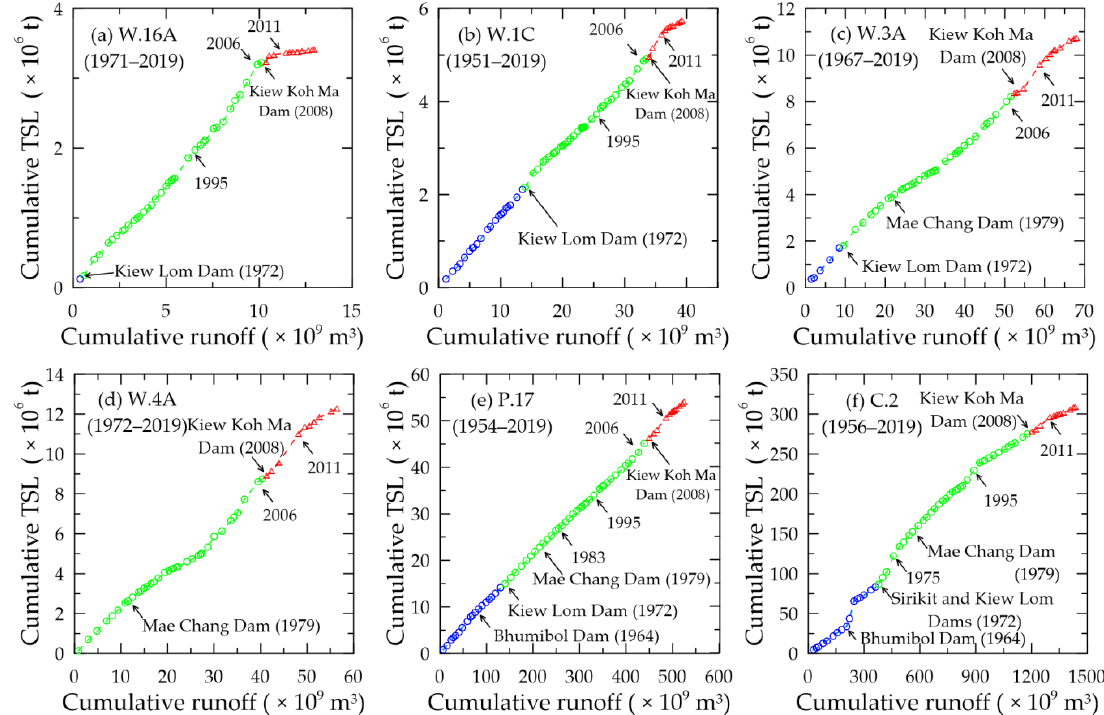
Figure 7. Plots showing cumulative annual runoff and total sediment load of the Wang River: ( a ) W.16A; ( b ) W.1C; ( c )